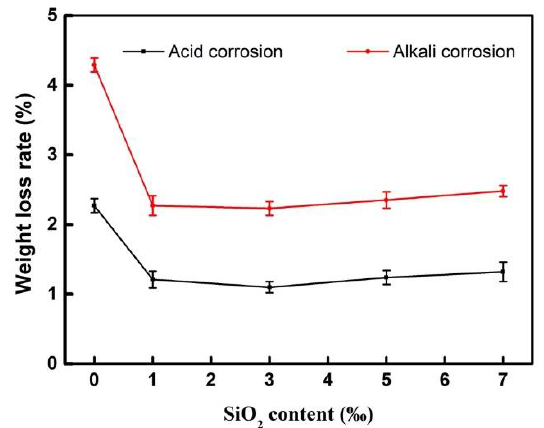
Figure 4. Weight loss rate of the modified BF epoxy resin coatings with different nano-SiO 2 contents in 3 mol/L HCl and 3 mol/L NaOH solutions.